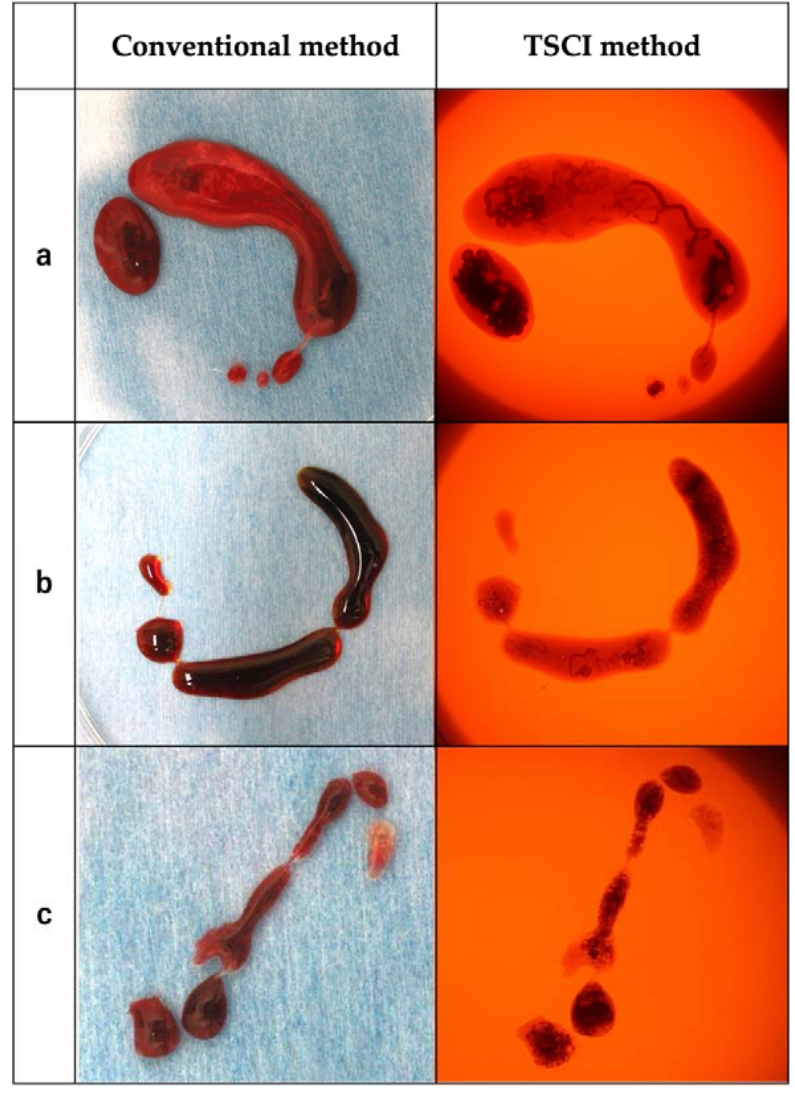
Figure 2. Representative EUS ‐ FNA sample images. The images of the EUS ‐ FNA samples from the three cases with puncture needles of different sizes were observed using the conventional and TSCI methods. The solid components and blood and tissue components are clearly distinguished by the transmitted light in the TSCI method. ( a ) AIP, needle size: 19G, median score (conventional/TSCI): 3.5/5; ( b ) Pancreatic cancer, needle size: 22G, median score (conventional/TSCI): 1/5; and ( c ) Pan- creatic cancer, needle size: 25G, median score (conventional/TSCI): 3.5/5. Abbreviations: AIP, autoimmune